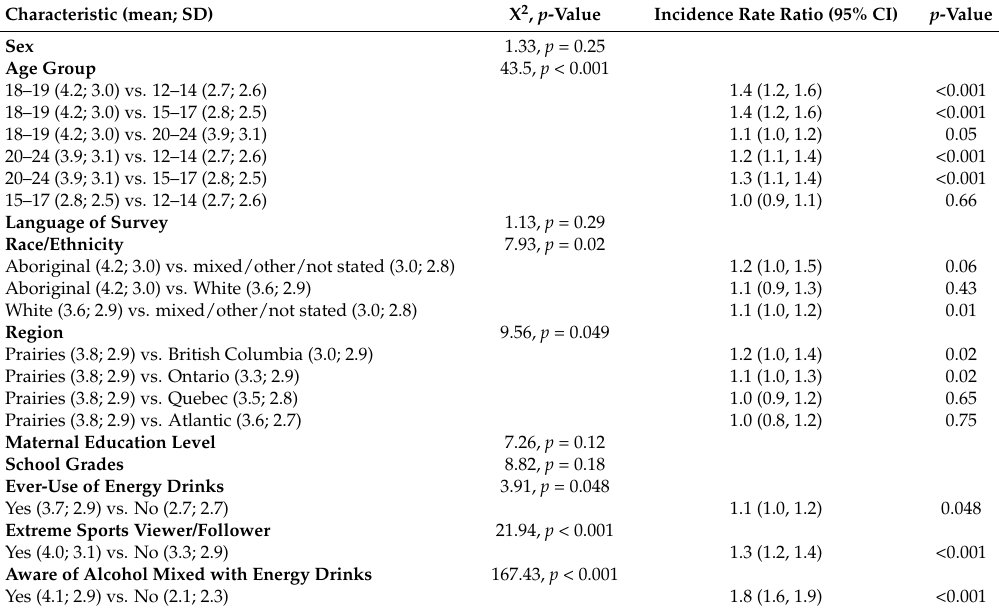
Table 3. Results from a negative binomial regression model, showing correlates of reporting a greater number of marketing channels, as defined by the Marketing Exposure Index (0–10) ( n = 2023). Characteristic (mean; SD) X 2 , p -Value Incidence Rate Ratio (95% CI) p